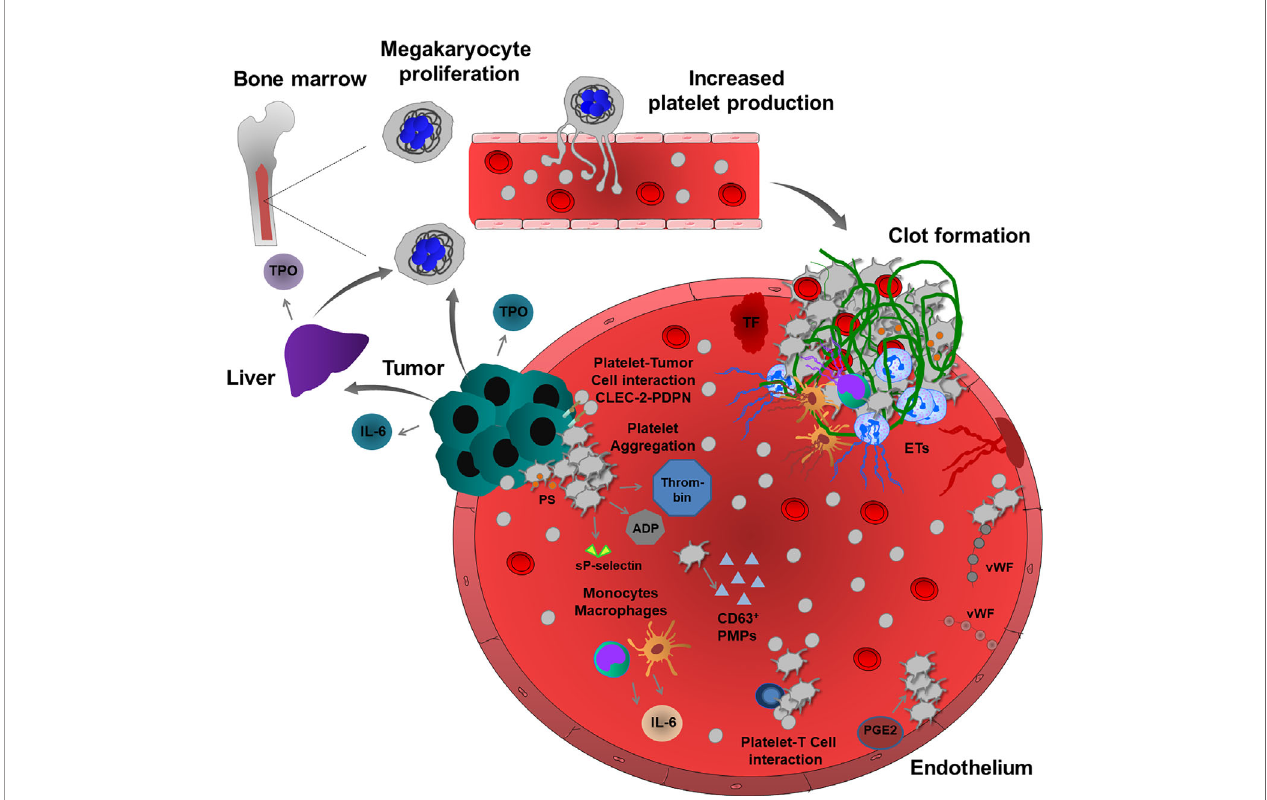
FIGURE 1 | Cancer-associated thrombosis and thrombo-in fl ammation. Growing tumors can induce thromboembolic events through several mechanisms. Tumor and immune cells (monocytes and macrophages) release in fl ammatory cytokines, such as IL-6, which regulate TPO levels in the liver, thereby enhancing the proliferation of megakaryocytes and consequent platelet production. Some tumor cells can also produce TPO, thereby increasing platelet production. In a pro- thrombotic tumor environment, TF and platelet and endothelial cell-derived vWF enhance platelet activation and aggregation. CLEC-2-PDPN-mediated interactions enhance platelet-tumor cell cross-talk and TCIPA. Activated platelets release many pro-coagulant factors and also sP-selectin and ADP. Increased thrombin generation and PS – exposure on the surface of activated platelets induce intravascular clotting and thrombosis. In addition, platelets and tumor microenvironment activate immune cells, such as neutrophils, monocytes, macrophages and also endothelium thereby promoting the release of ETs, further inducing in fl ammation, platelet activation, aggregation and fi brin-rich clot formation. During cancer progression, platelets also interact with T cells to enhance thrombosis. In addition, endothelial PGE2, PMPs and extracellular vesicles can also enhance platelet activation and induce thrombosis and thrombo-in fl ammation in growing